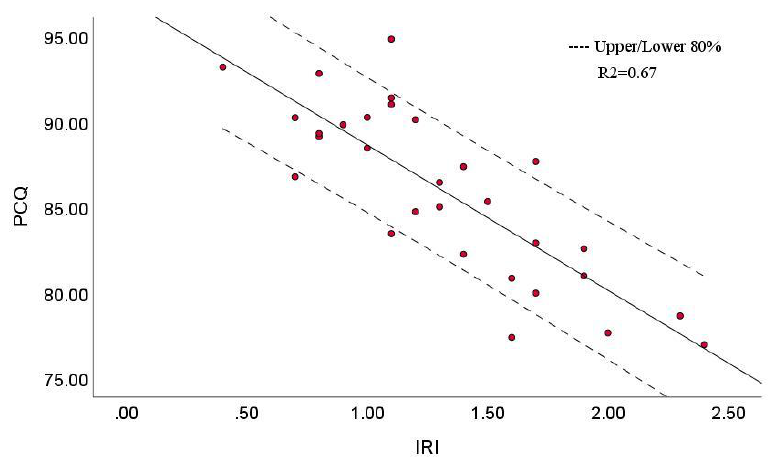
Figure 9. Correlation analysis between PCQ and PCI.